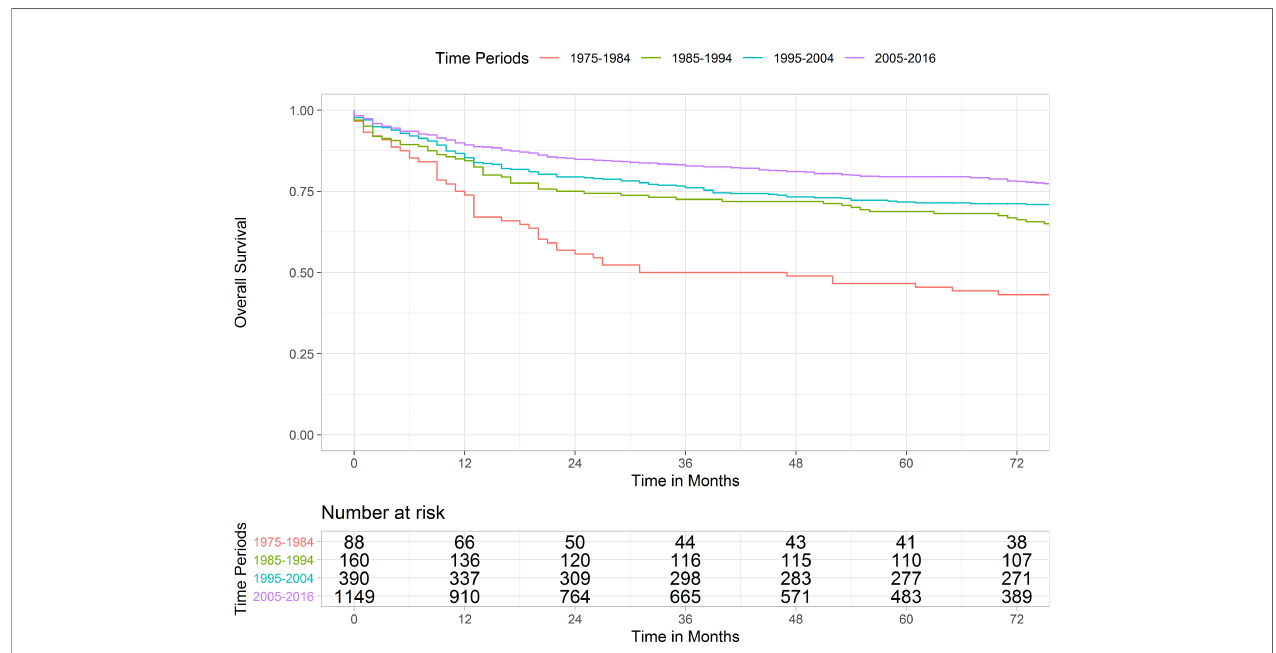
FIGURE 1 | Kaplan Meier curve illustrating the survivals of pineal gland tumors over four periods. Pairwise comparison results were as followed: 1975-1984 versus 1985-1994, p -value < 0.001; 1985-1994 versus 1995-2004, p -value = 0.860; 1995-2004 vs. 2005-2016, p -value = 0.003.